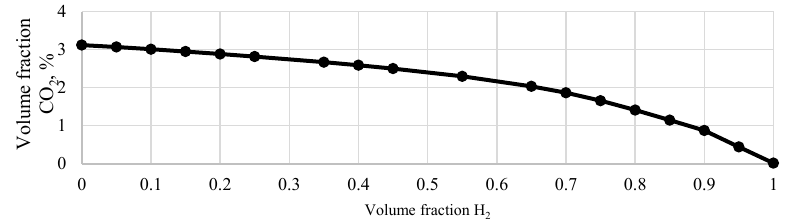
Figure 11. Effect of hydrogen volume fraction on carbon dioxide emissions.